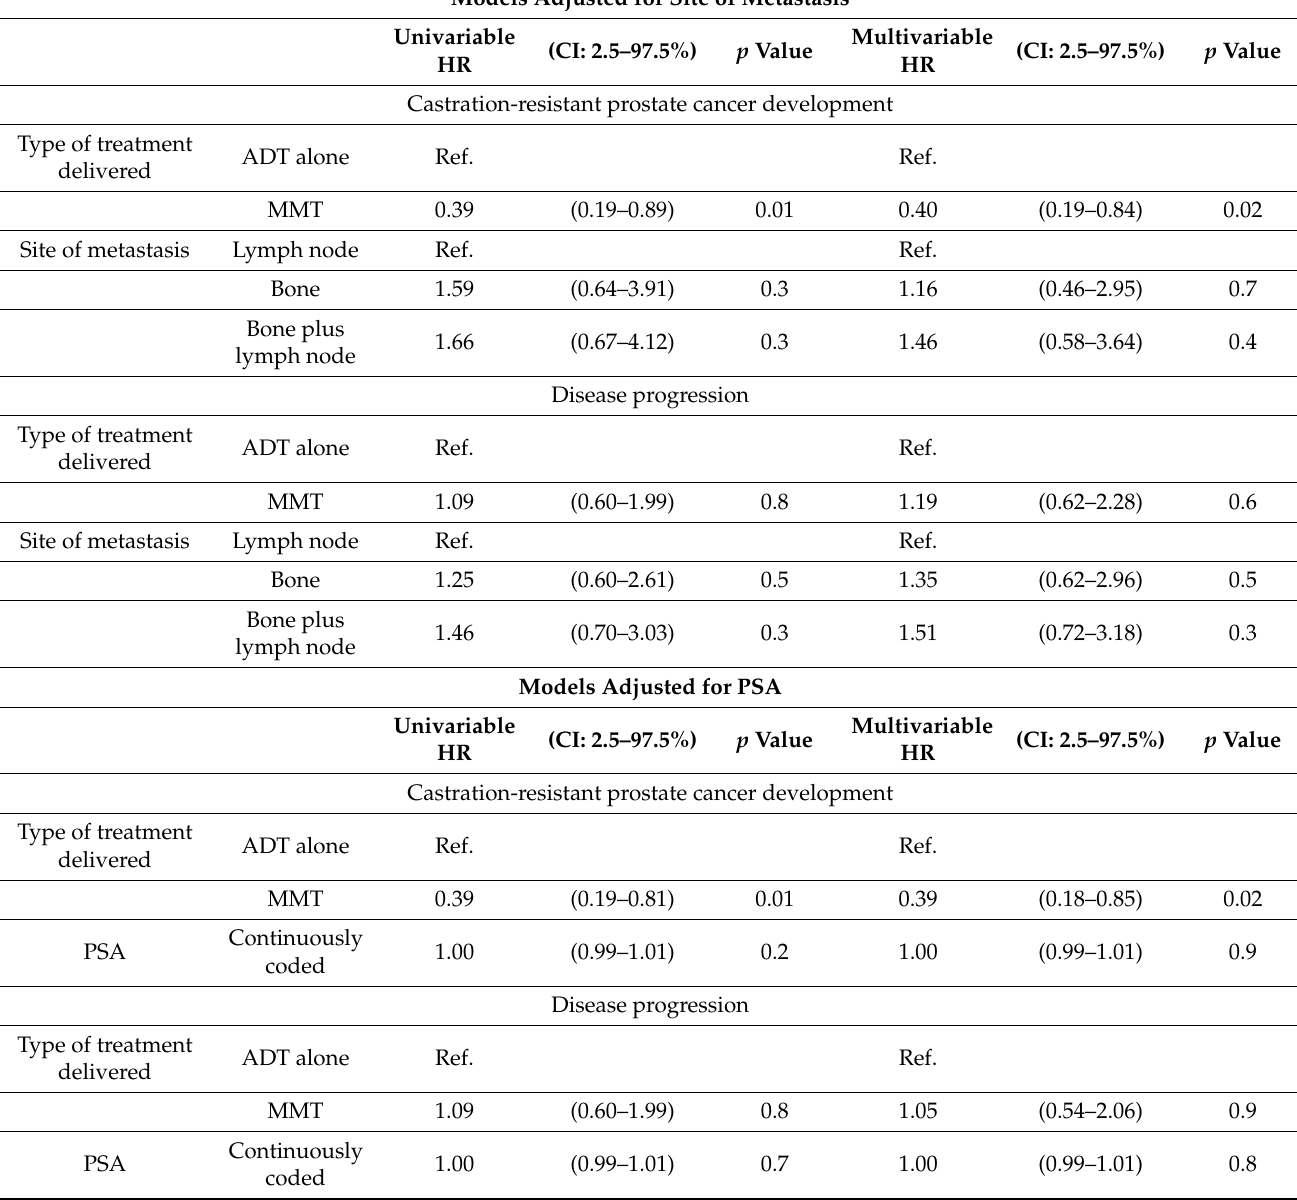
Table 2. Univariable and multivariable Cox regression models predicting castration-resistant prostate cancer development and disease progression according to treatment delivered (MMT vs. ADT alone). Two separate models are reported. The first model was adjusted for the site of metastasis (defined as bone vs. lymph node vs. bone plus lymph node); the second model was adjusted for PSA (continuously